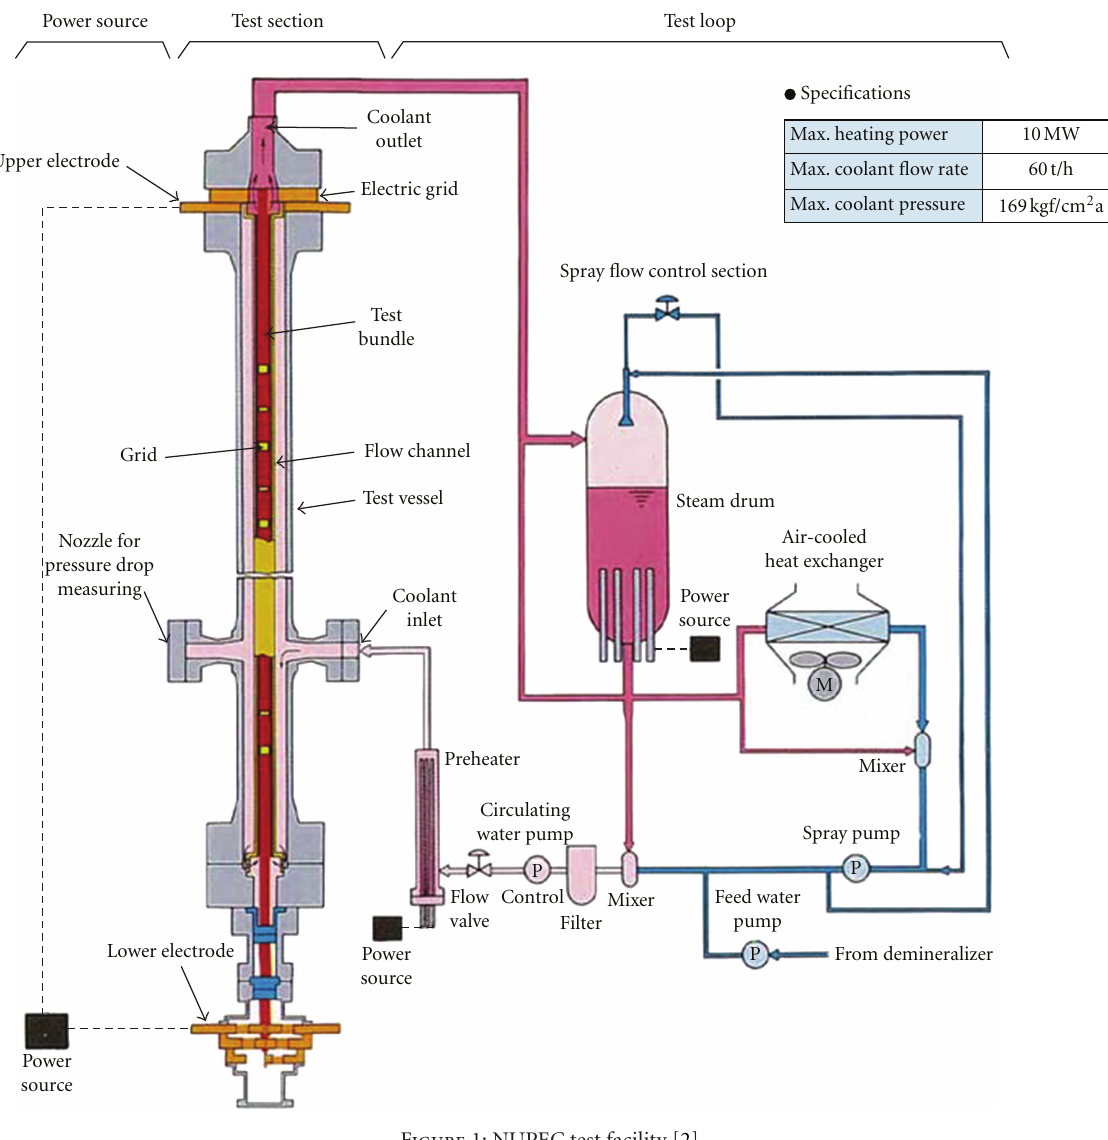
Figure 1: NUPEC test facility